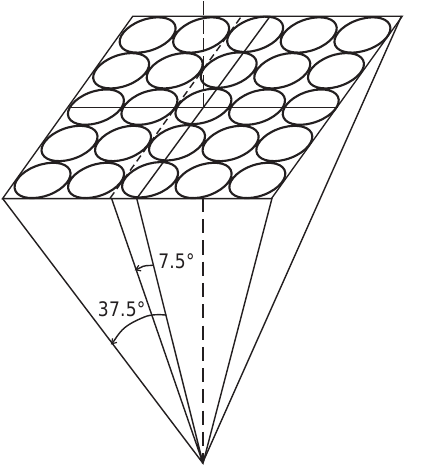
Fig. 1. Technique for enhancing ELF radiated power by scanning the HF beam over an area within the antenna beam angle of (cid:6) 37 : 5 (cid:14) (see Papadopoulos et al. ,